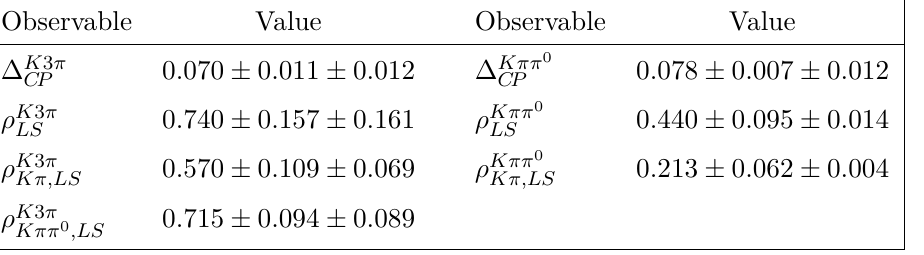
Table 10 . The measured CP -tagged and like-sign global observables for the modes D → K − π + π + π − and D → K − π + π 0 . The first uncertainty is statistical and the second systematic.